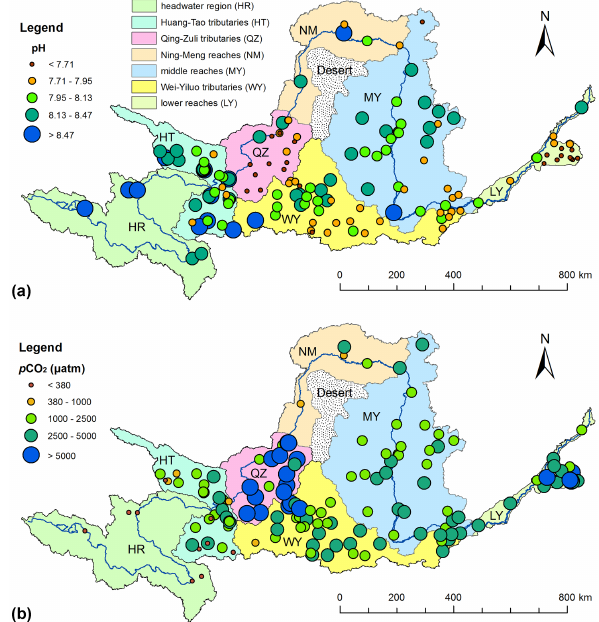
Figure 2. Spatial variations of pH (a) and p CO 2 (b) in the Yellow River